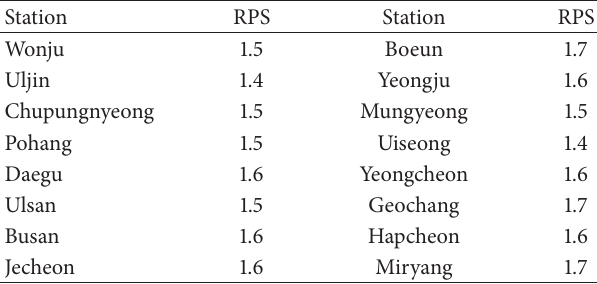
Table 2: Average RPS values for 16 stations during September 2008 to December